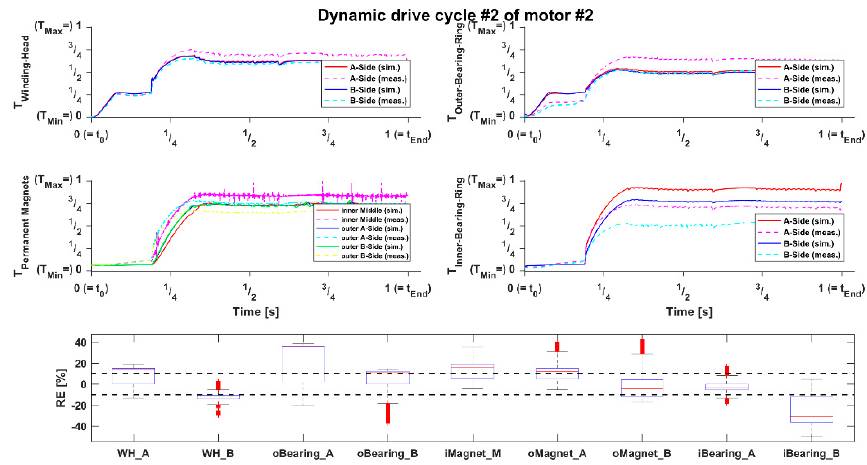
Figure 8. Drive cycle simulation vs. measurement of motor #2 and #3.